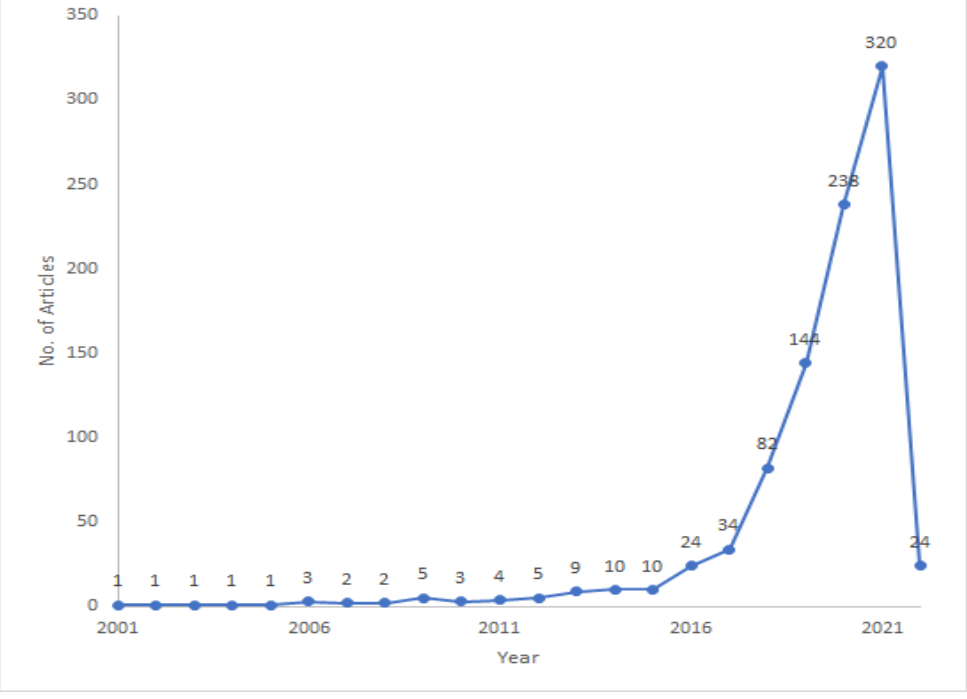
Figure 2. Number of publications on air pollution and machine learning since 2012.